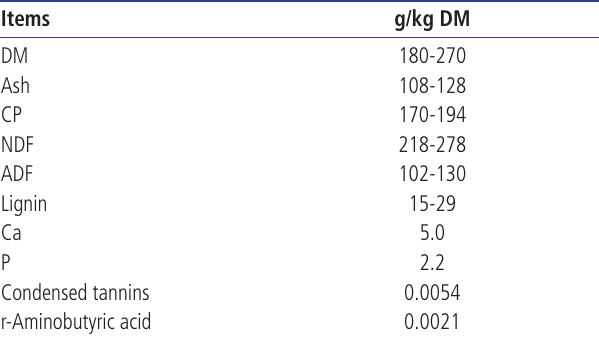
Table 1. Chemical composition of mulberry leaf